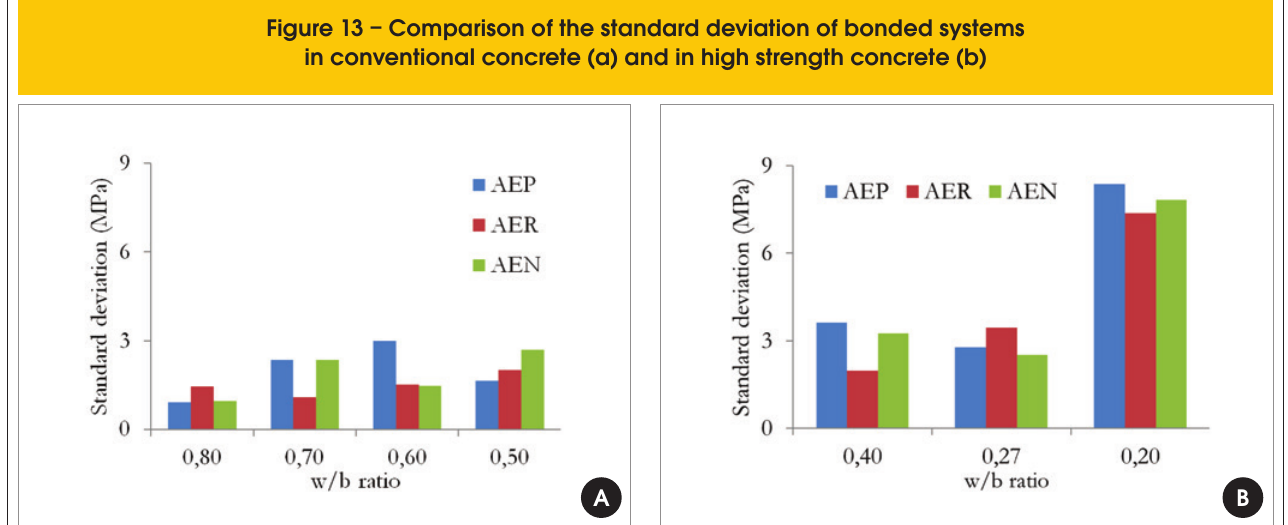
Figure 13 – Comparison of the standard deviation of bonded